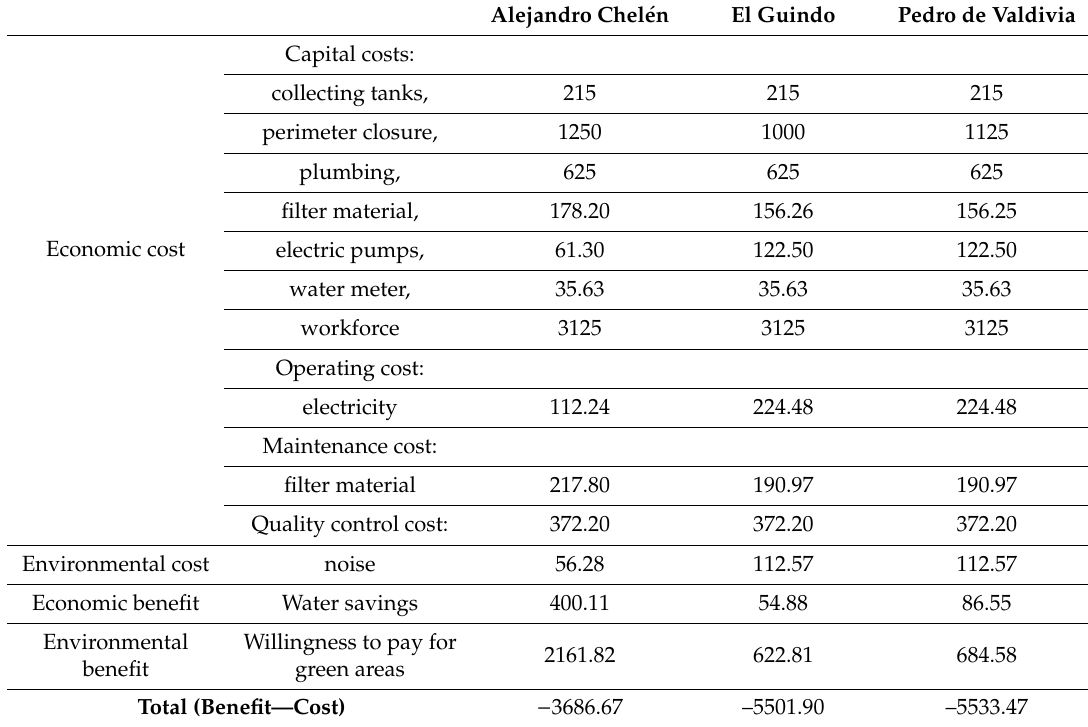
Table 4. Economic costs and benefits of the projects evaluated at 10 years